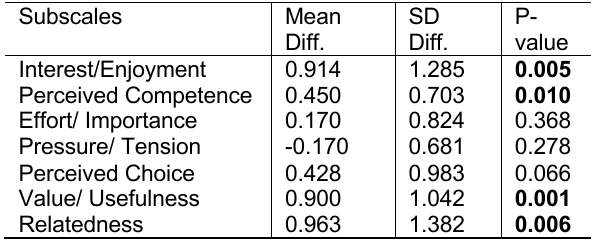
Table 1. Results of the Intrinsic Motivation Inventory